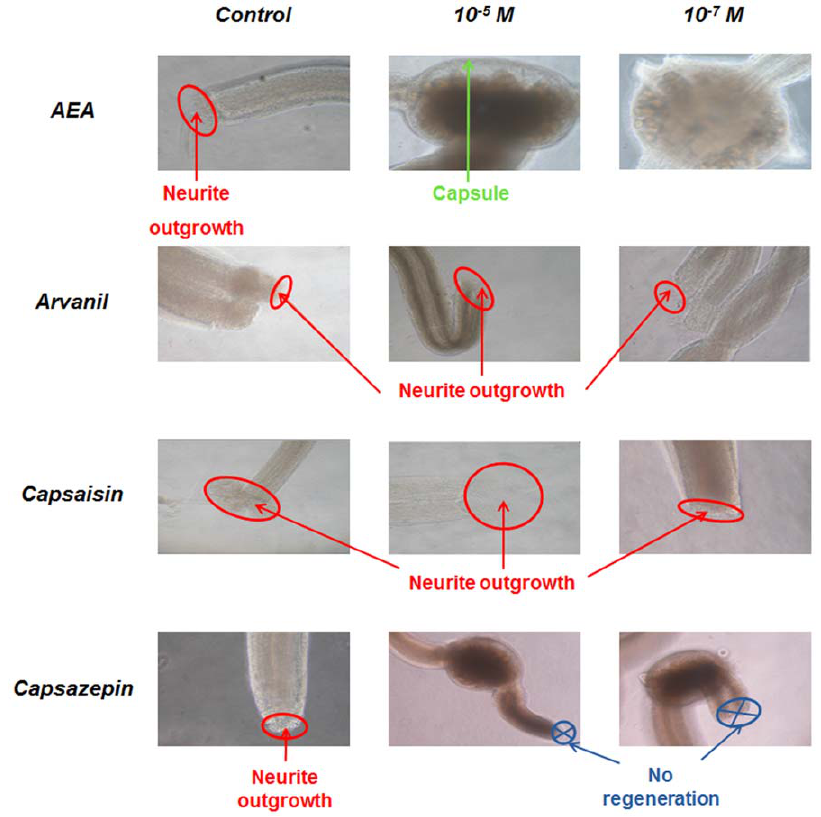
Figure 8. Cannabinoids affect neurite outgrowth from cut nerves in cultured segments of the CNS. In vitro leech nerve cord culture and neurite outgrowth assays with arvanil, capsaicin, capsazepin at concentration of 10 2 5 M or 10 2 7 M. Neurite outgrowth is indicated as well as the ones non regenerating.